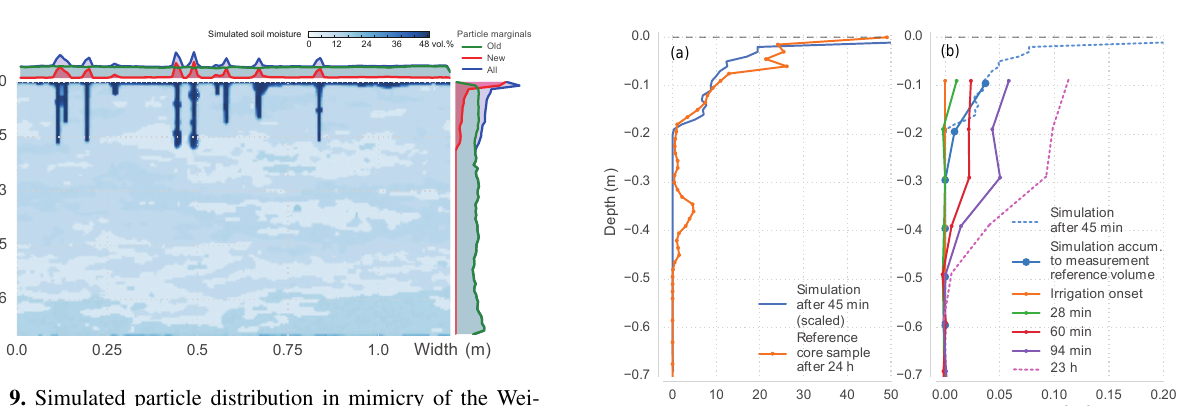
Figure 9. Simulated particle distribution in mimicry of the Wei- herbach, 40min after irrigation onset. A video of the simulated dy- namics is given in the Supplement.